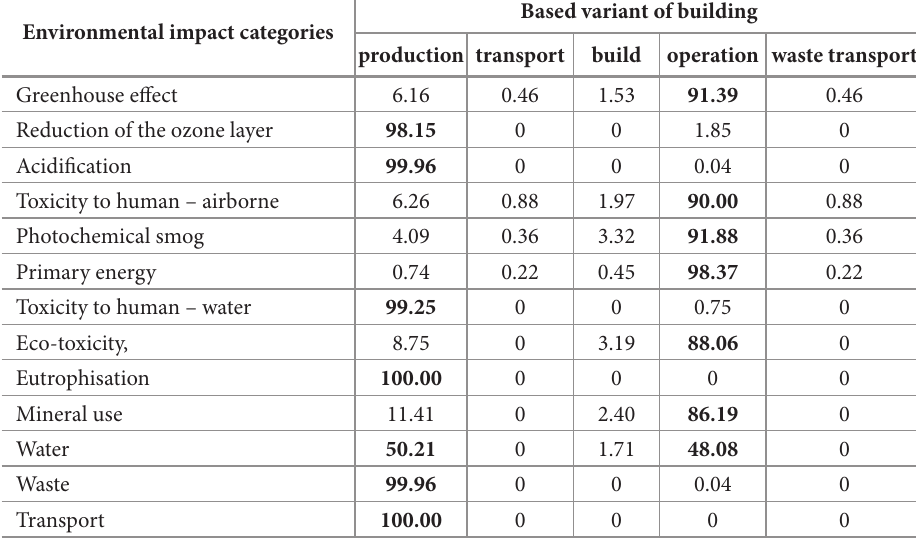
Table 5. Per cent share of the environmental impacts in individual phases of the life cycle Environmental impact